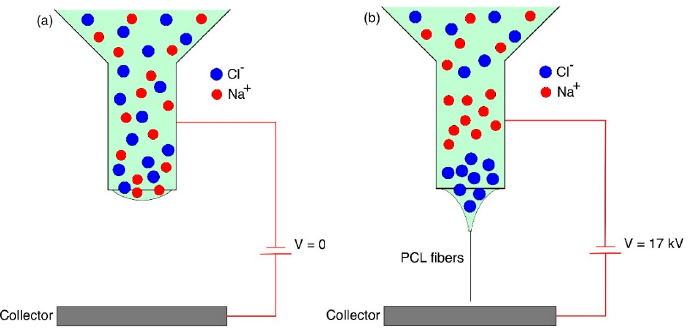
Figure 8. The schematic diagrams explain the dispersion of Na + and Cl - in the PCL melt when the high voltage is ( a ) off, ( b )